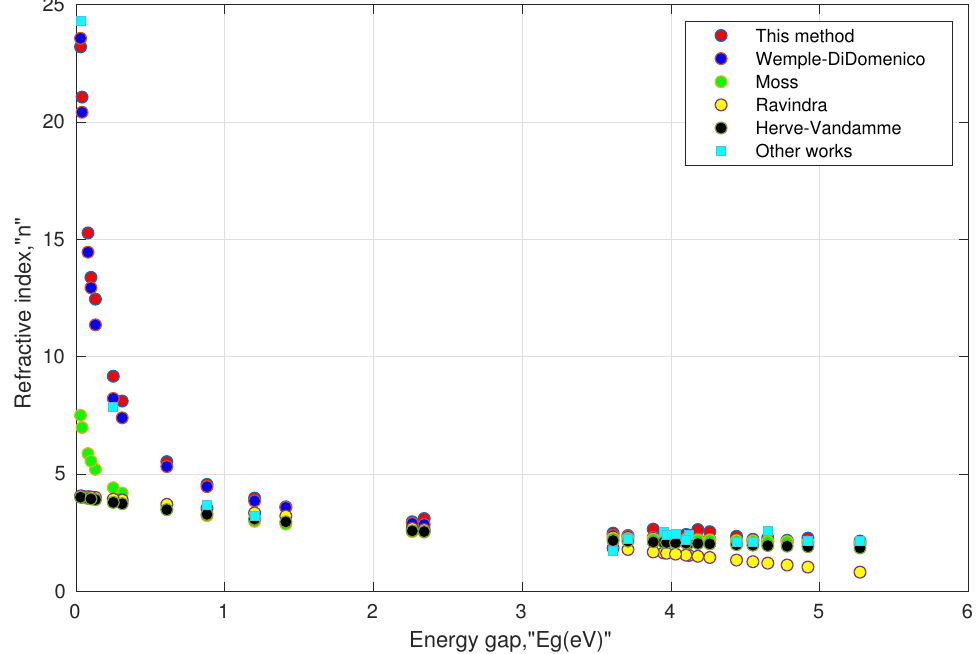
Figure 2. Simulated behavior of various models for oxide perovskites, shown in Table